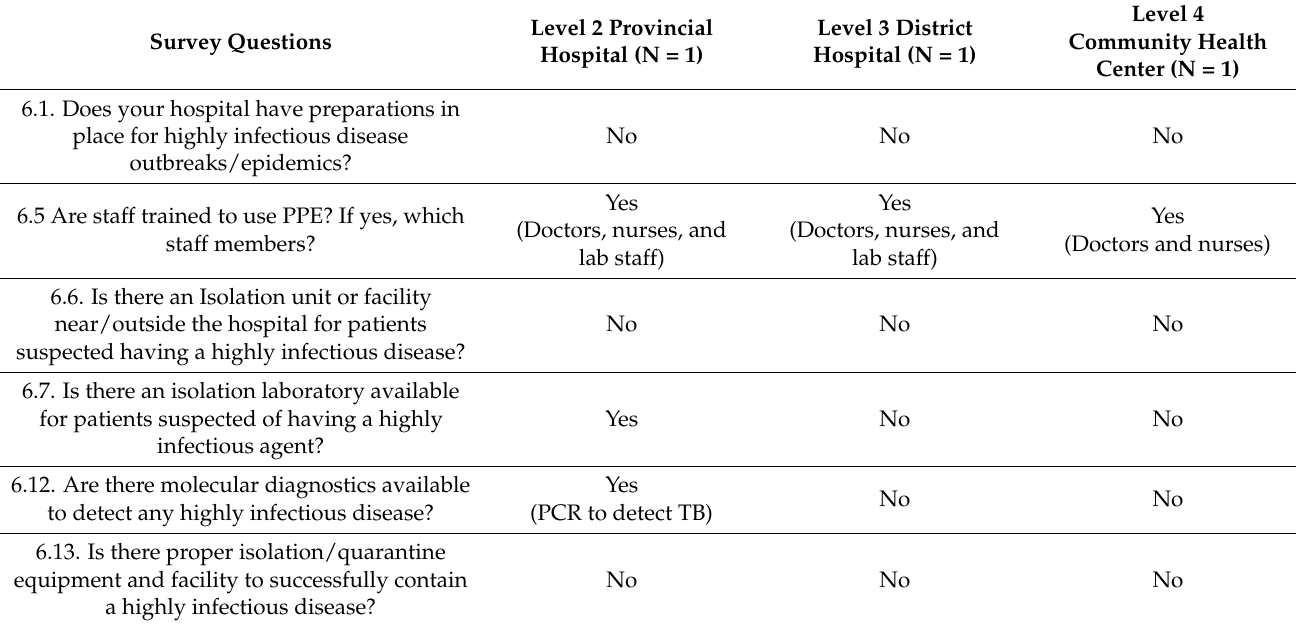
Table 7. Hospital preparedness for patients with highly infectious diseases.